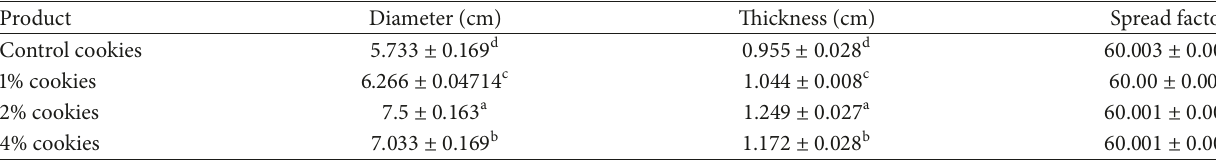
Table 5: Physical characteristics of cookies with added 𝛽 -glucan compared to the control cookies.